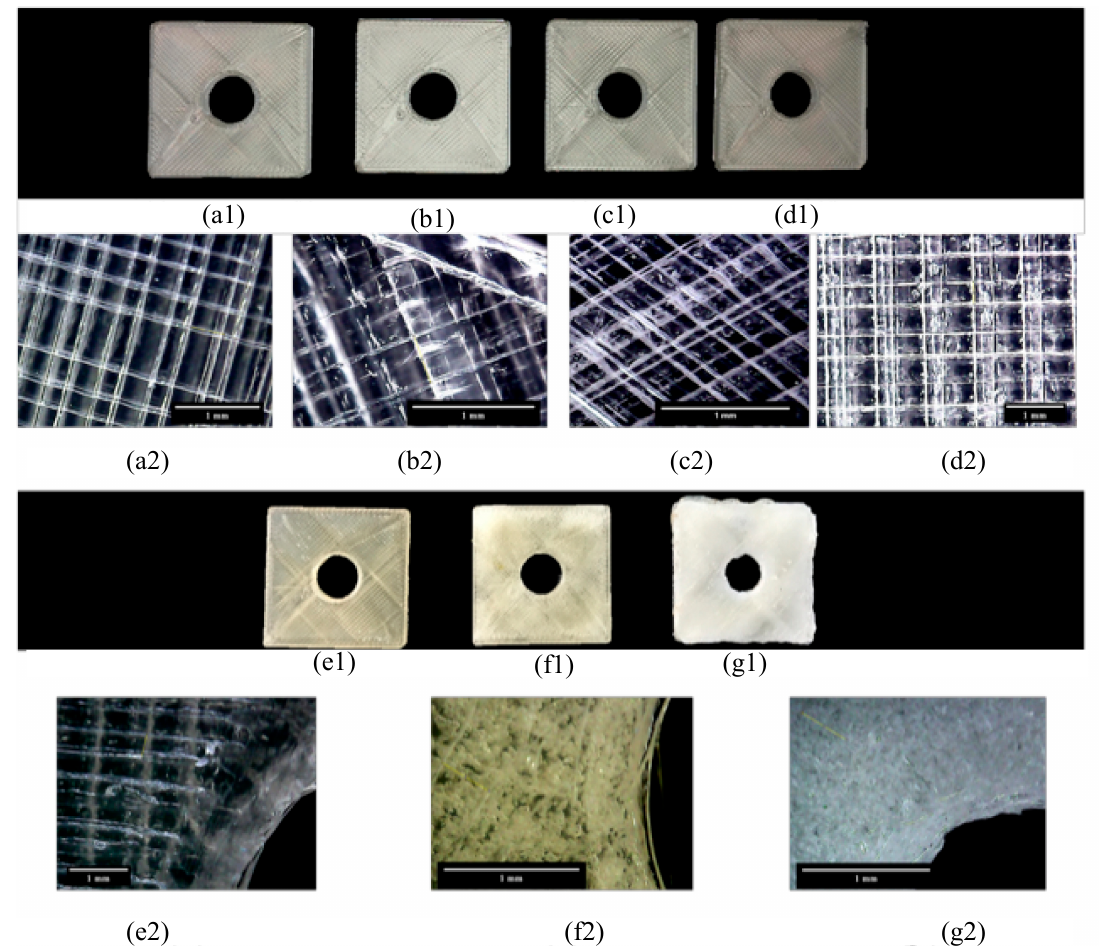
Figure 3. Photographs showing the effects of moisture in filaments on EBAM manufactured parts. Figure ( a1 ), ( b1 ), ( c1 ) and ( d1 ) are images of MM4520 printed parts manufactured with filaments immersed in water for 0, 10 min, 5 h and 24 h. Figures ( a1 ), ( b2 ), ( c2 ) and ( d2 ) show zoomed-in views of the printed surfaces. Similarly ( e1 ), ( f1 ) and ( g1 ) are images of MM7520 printed parts manufactured with filaments immersed in water for 0, 10 min and 24 h, the close-up versions are shown in ( e2 ), ( f2 ) and ( g2 ).